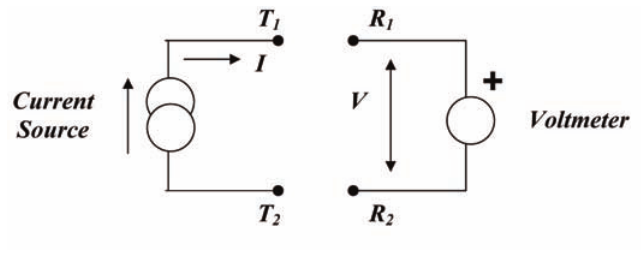
Figure 1. Equivalent circuit of the quadrupole